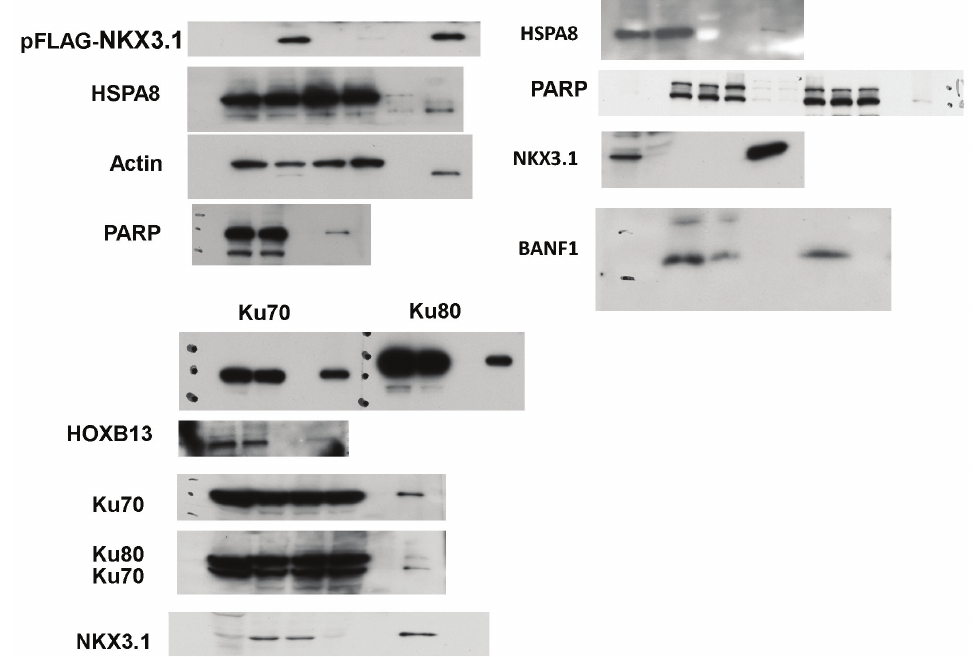
Figure S7. Uncropped immunoblots for Figure